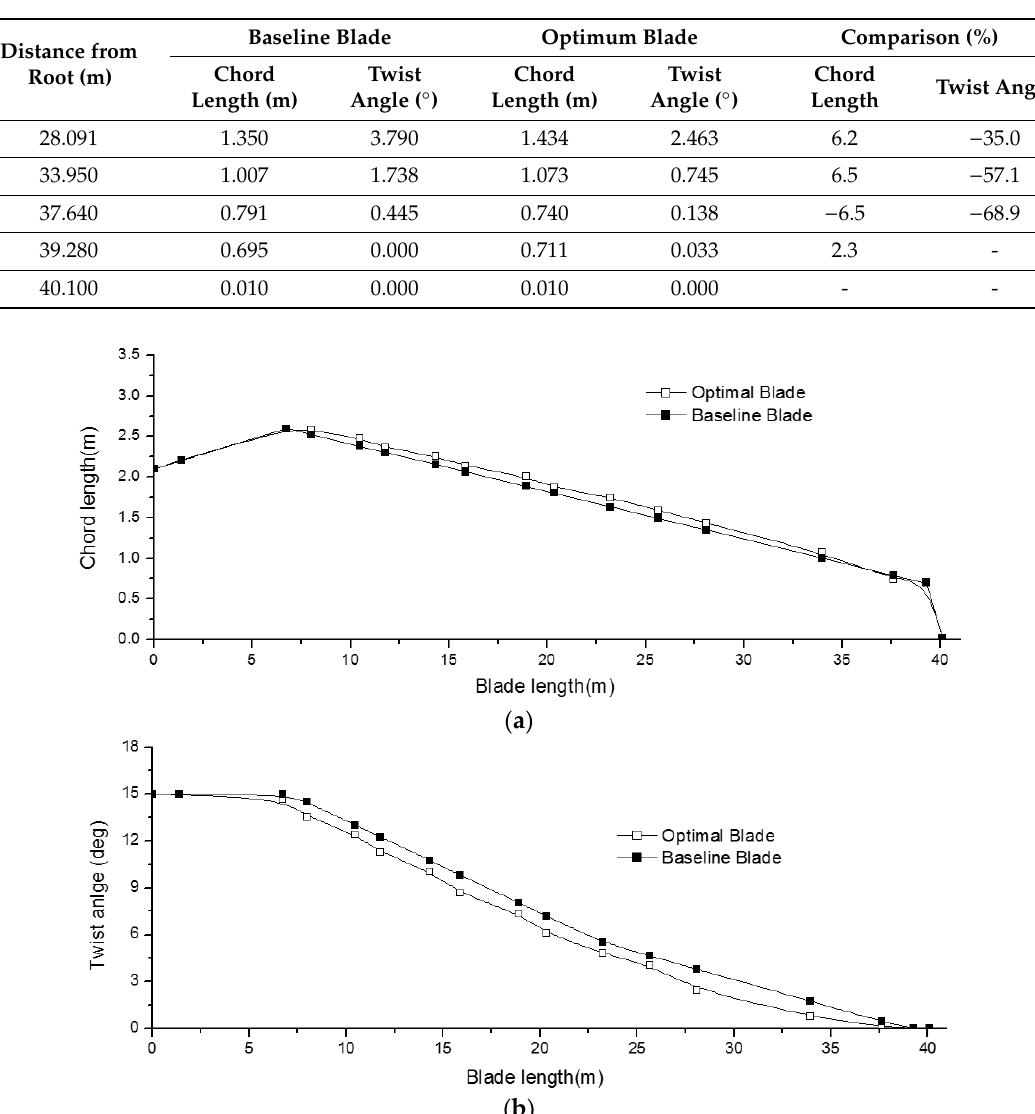
Figure 9. Comparison between the optimal and baseline geometry. ( a ) Chord length distribution. ( b ) Twist angle distribution.